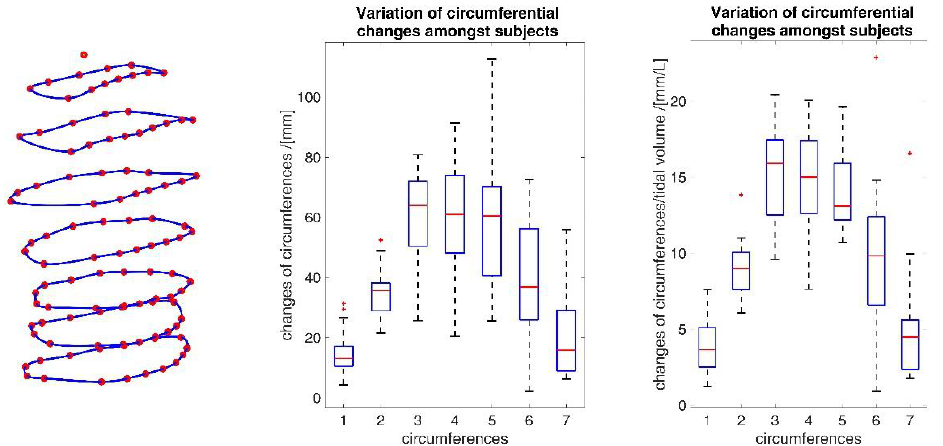
Figure 19. Inter-individual variability of circumferential changes amongst all subjects during maximal breathing ( middle ) and variability of circumferences considering different inspired tidal volumes ( right ). The blue numbers identify the circumferences as shown ( left ). The deployed box and whisker plot illustrates the minimum value, 25% percentile, median, 75% percentile, the maximum value and the red + signs denote outliers.